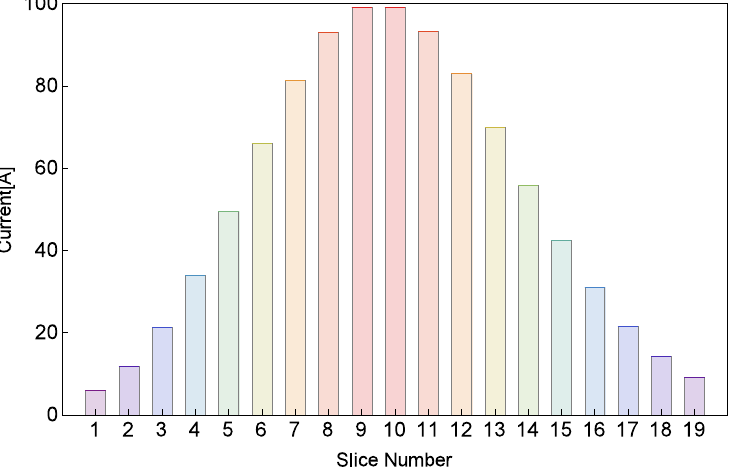
Figure 7. Slice number sampling and shape, using the e-bunch distribution as the reference